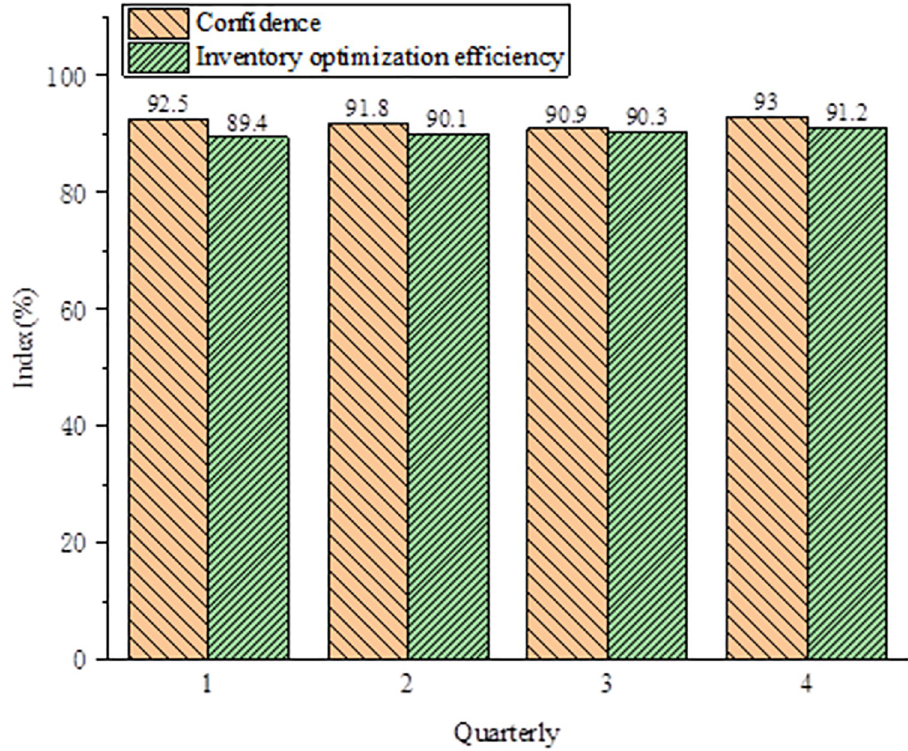
Fig 11. Confidence and inventory optimization efficiency of DPMES prediction results based on sample data inside and outside the platform.